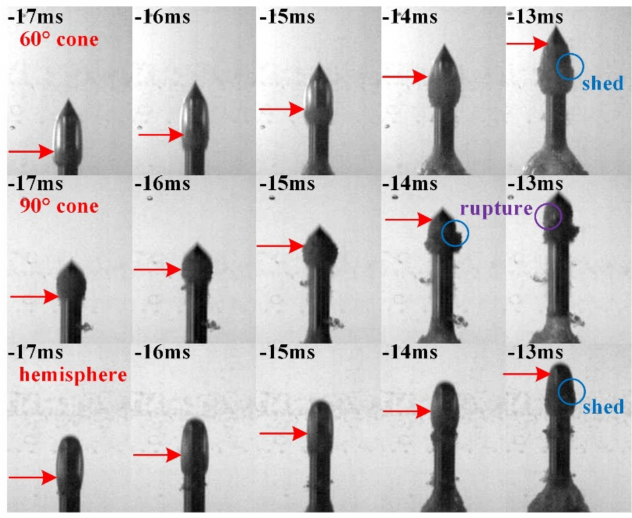
Figure 6. Development process of the re-entry jet.